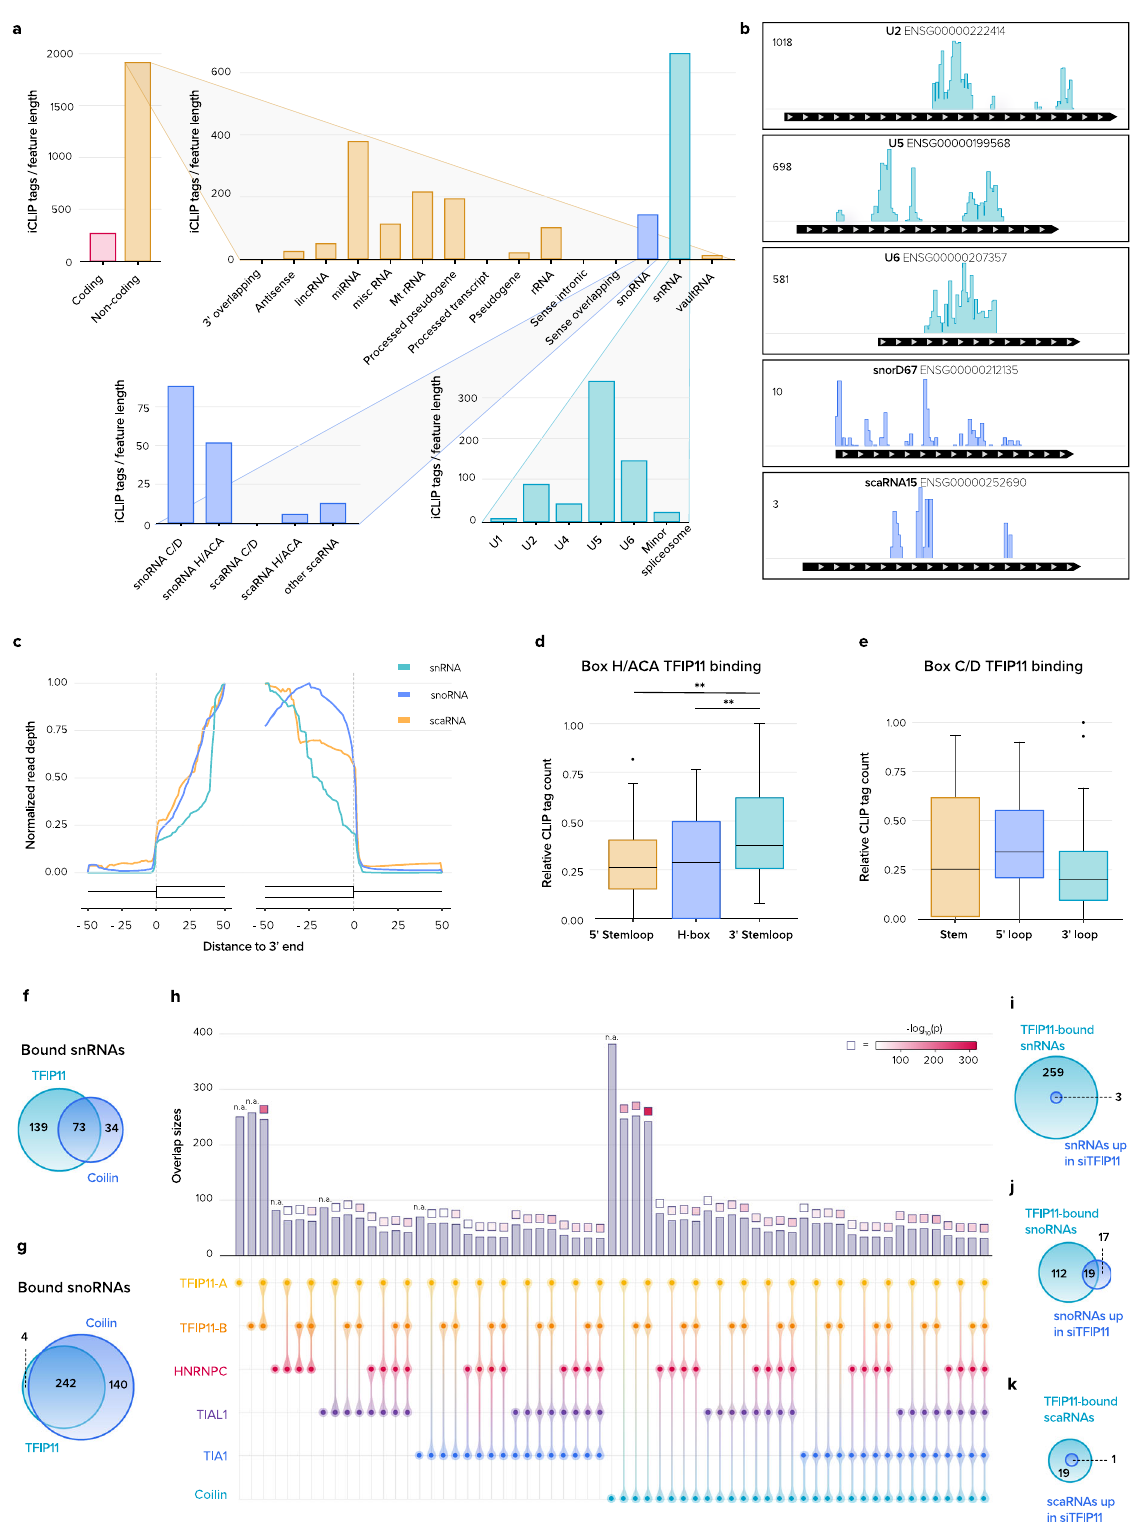
TFIP11 is required for mitosis and cell survival . Gene Ontology (GO)-term analysis using DAVID was performed on genes with differential intron retention and showed that genes involved in mitosis and cell division were aberrantly spliced in TFIP11- depleted cells (Fig. 8a and Supplementary Data 2). This prompted us to investigate the cellular consequences of TFIP11 knockdown. Live-imaging experiments revealed aberrant mitotic progression